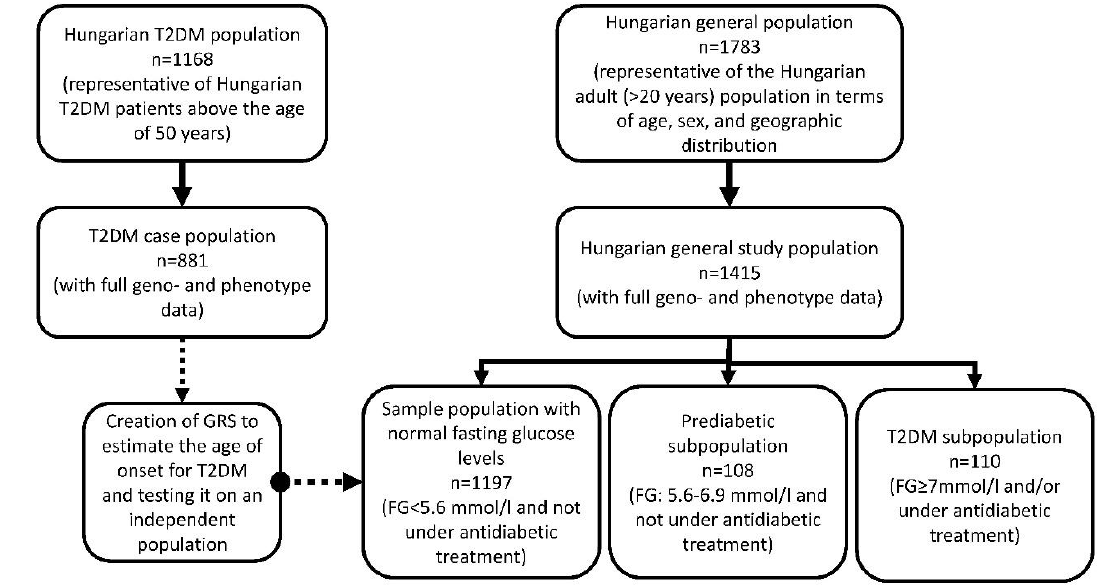
Figure 1. Flowchart showing the processes of sample selection, the stratification of the HG population, and the development and use of the GRS instrument.